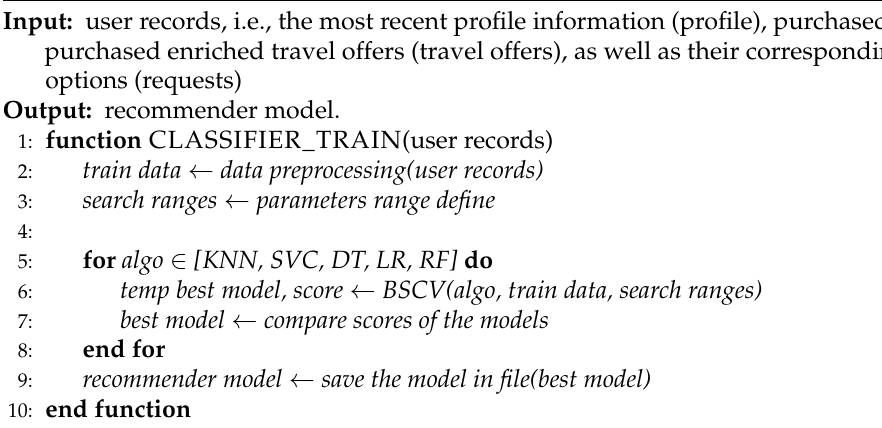
Algorithm 3 Recommender Model